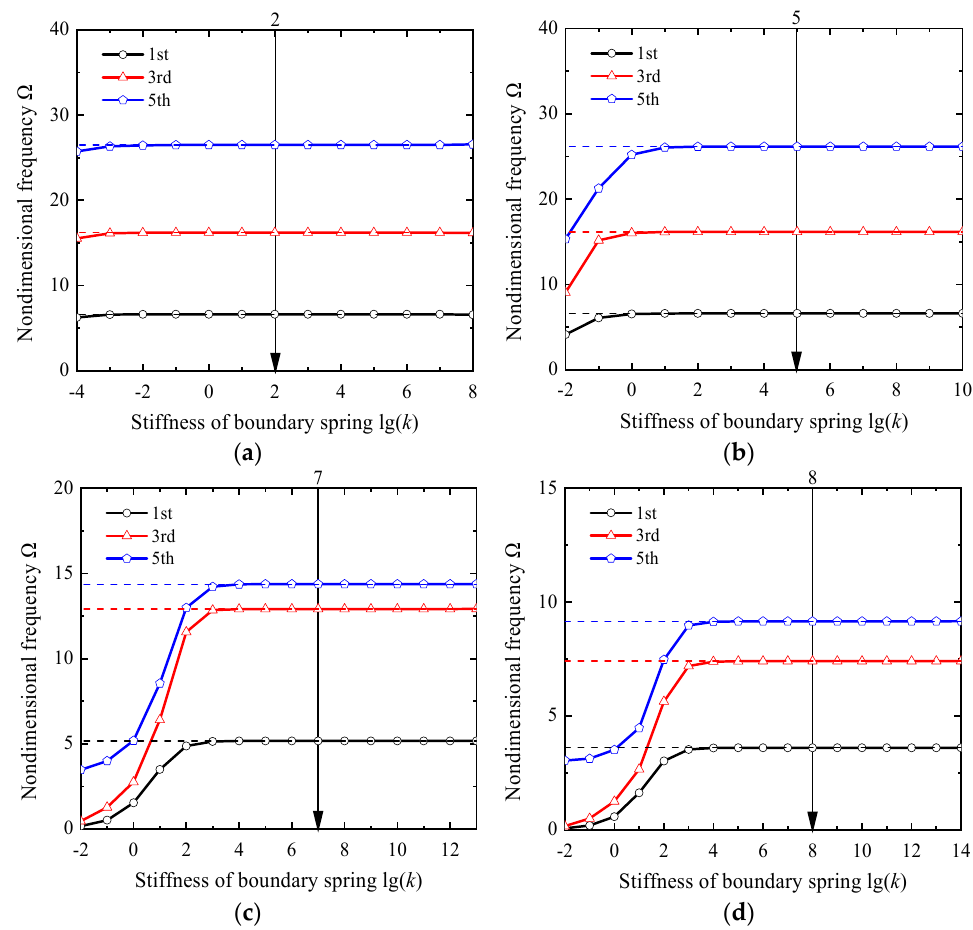
Figure 8. Variations of nondimensional frequencies Ω for SSSS laminates (0°, 90°, 0°) versus the stiffness of boundary spring ( k t = k r 2 = k , k r 1 = 0): ( a ) h/b = 0.001; ( b ) h/b = 0.01; ( c ) h/b = 0.1; ( d ) h/b = 0.2.